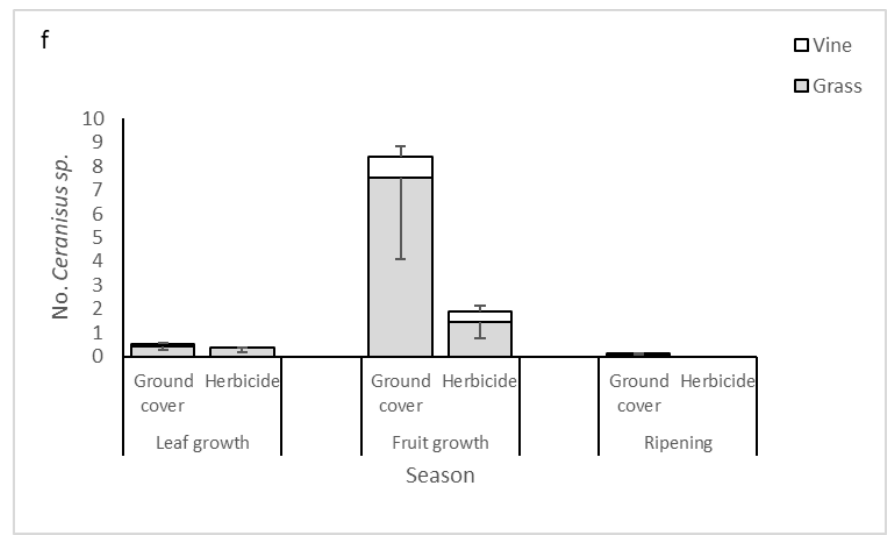
Figure 2. Mean ± SE abundance of all parasitoids combined ( a ) and of the five dominant species in the suction samples from the grass (grey bars) and vine (white bars) habitats. ( b ) Anagrus sp.; ( c ) Lymaenon litoralis ; ( d ) Telenomus sp.; ( e ) Oligosita sp.; ( f ) Ceranisus sp. * denotes a significant difference between treatments in Tukey’s post-hoc test ( p < 0.05). Table 1. Results from Linear Mixed Models showing the effect of explanatory variables on the abundances of all parasitoids, each of the five dominant parasitoid species/morphospecies, and two groups of potential hosts. Variables selected by maximum likelihood ratio tests with p < 0.1 are shown: df, degrees of freedom; LRT, likelihood ratio test statistic.